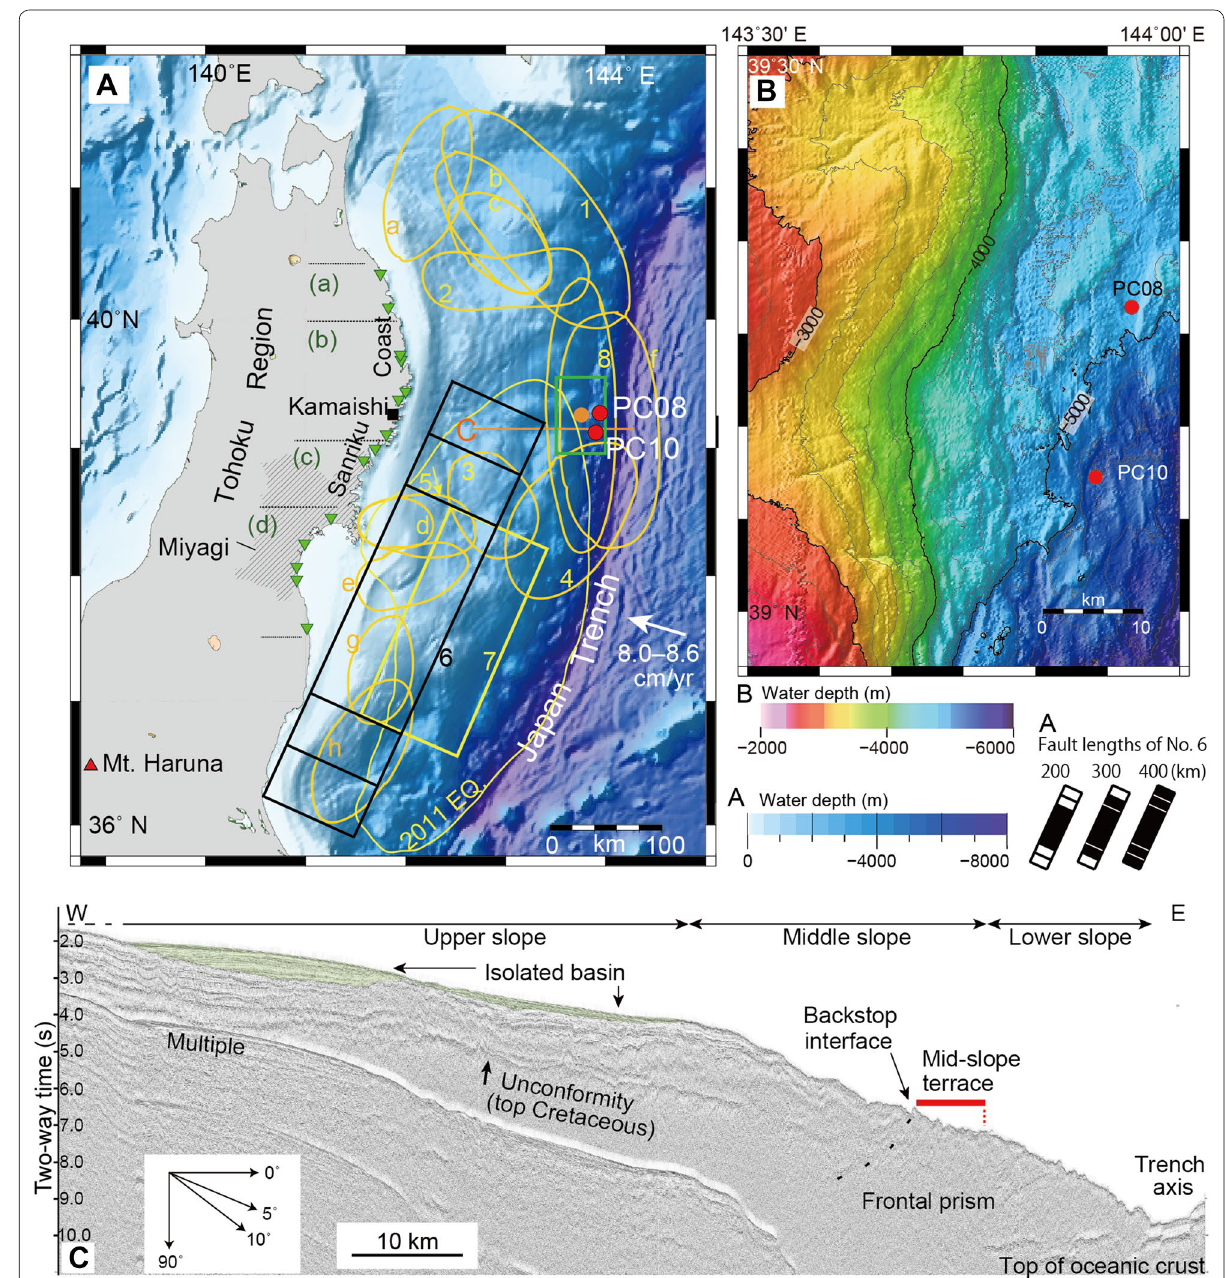
Fig. 1 A Bathymetric image along the Japan Trench. Two red circles indicate coring sites of NT13–19 PC08 and PC10. The orange point to the left of the coring sites is the hypothetical source of the turbidity currents for calculating PGA in this study. Line C transects the inset in C . Green inverted triangles indicate the sites of onland tsunami deposits (Sawai et al. 2012; Hirakawa 2012; Takada et al. 2016; Ishimura 2017). Yellow ellipses summa- rize the suggested rupture areas of historical earthquakes ( M ~ 7.4 and larger) over the most recent 200 years (Koper et al. 2011; Toda 2016); 2: 1994 Sanriku-oki earthquake, 8: 1896 Sanriku earthquake. The rectangles with black solid lines are the suggested rupture areas of the 869 Jogan earth- quake (Namegaya and Satake 2014). The rectangle with yellow solid lines is the suggested rupture area of the 1454 Kyotoku earthquake (Sawai et al. 2015). Numbers (1–8) of the rupture areas correspond to those in Additional file 7: Table S3. Irregular ellipses with yellow solid line indicate the area of coseismic slips, which were 4 m or greater when the 2011 earthquake occurred (Ozawa et al. 2011). Earthquakes other than those mentioned above (a–i) occurred in the following years: (a) 1856, (b) 1931, (c) 1901, (d) 1897, (e) 1936, (f) 1933, (g) and (h) 1938. The bathymetric chart (shaded- relief) is based on ETOPO1 (Amante and Eakins 2009). B Detailed bathymetry of the coring sites at NT13-19 PC08 and PC10. This inset is indicated by the green rectangle in A . Both coring sites PC08 and PC10 are in small basins in the MST. The bathymetric chart (shaded-relief) is based on a data- set provided by the Hydrographic and Oceanographic Department, Japan Coast Guard. C Migrated seismic profile of line C in A . Green areas show isolated basins above the onlap